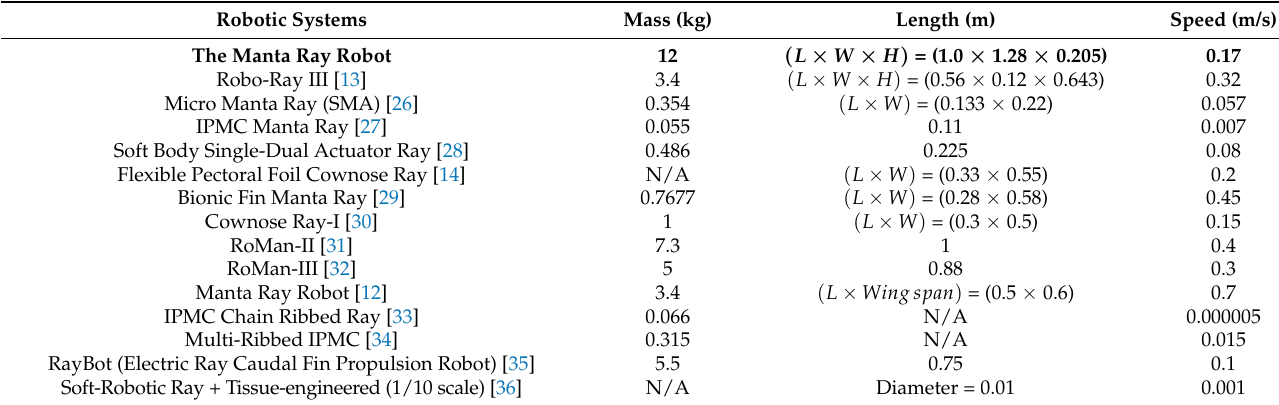
Table 4. Comparison with other manta ray type robot.